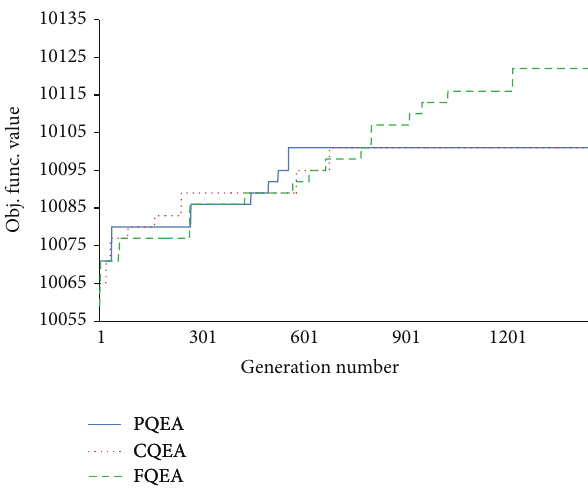
Figure 27: Convergence graph of PQEA, CQEA, and FQEA on 0-1 knapsack problem with profit ceiling data instances with number of items, 𝑀 , being 200 and capacity, 𝐶 , being 10% of total weight.